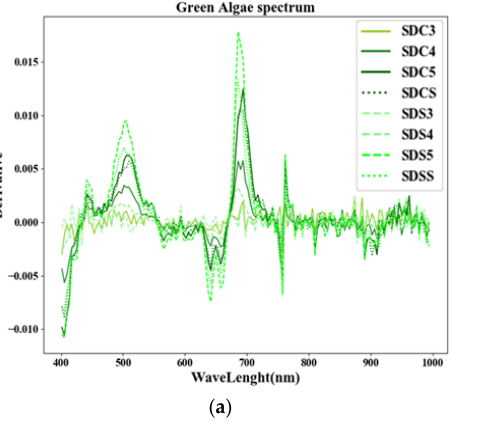
Figure 9. Graph of derivative algae result. (( a ) Green algae derivative spectrum—derivative spectrum results of green algae in the 400–1000 nm range; ( b ) blue-green algae derivative spectrum—the results of the derivative spectrum for blue-green algae in the 400–1000 nm range).